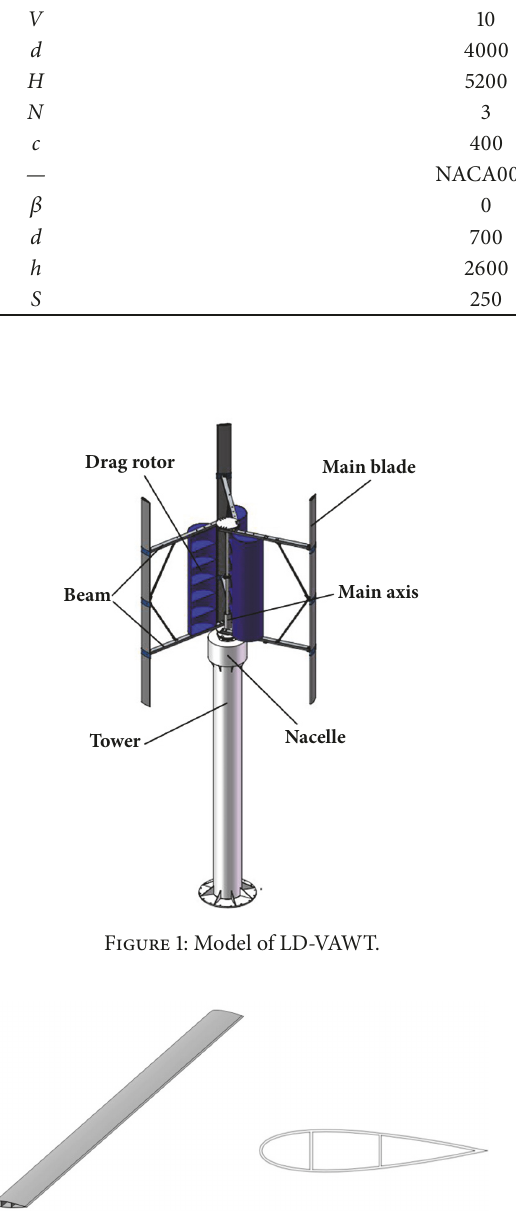
Figure 2: The structure of main